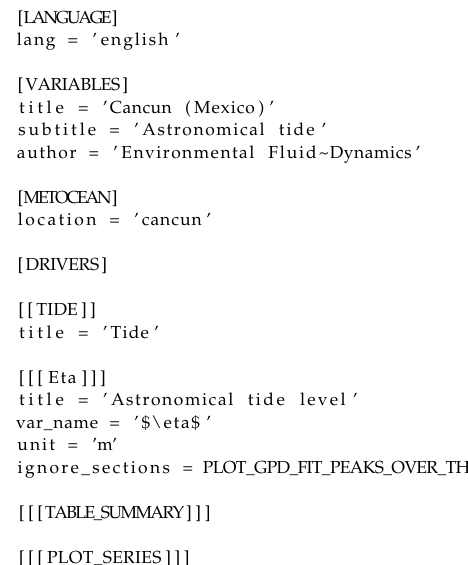
Figure 4. User-friendly report generated automatically from the tool. Listing 1: Extract of a report